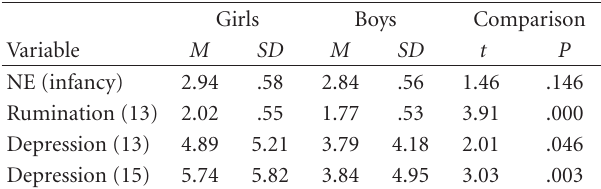
Table 1: Descriptive statistics for overall negative emotionality, rumination, and depressive symptoms, by gender.